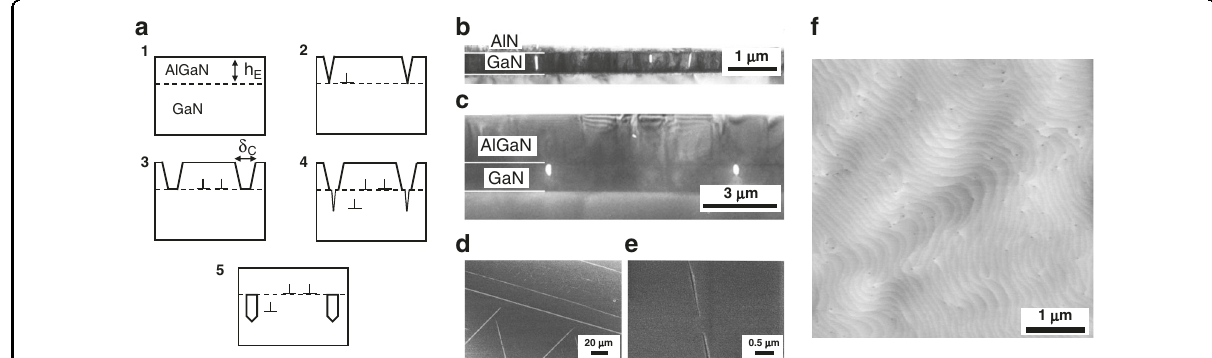
Fig. 3 Control of stress and strain during AlGaN/AlN epitaxial growth. a Schematic diagram of relaxation process: (1) coherent growth below the critical thickness; (2) AlGaN cracks and MDs are introduced at AlGaN/GaN interface; (3) Relaxation resulted from dislocations enlarges the crack aperture; (4) cracks propagate to the GaN layer, MDs relaxing in GaN; (5) lateral growth buries cracks. Cross-sectional XTEM images of b MBE-grown AlN and c MOCVD-grown Al